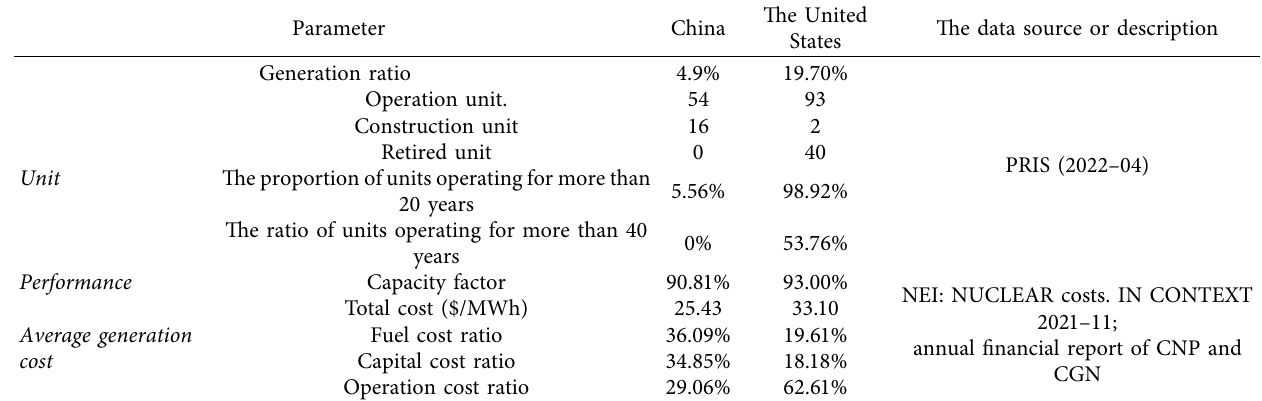
Table 1: Nuclear power operation data between China and the United